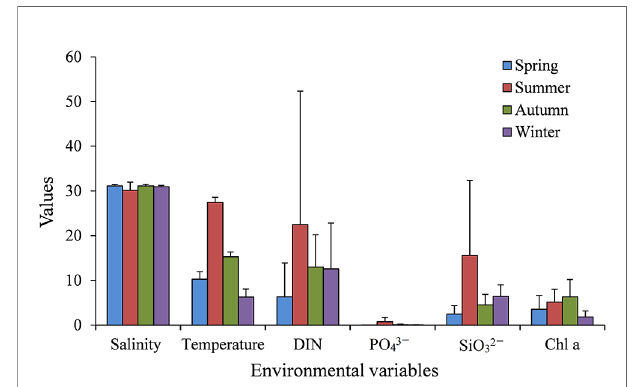
FIGURE 2 | Seasonal average values of key environmental variables, including salinity, temperature, DIN ( m M), PO 3 − 4 ( m M), SiO 2 − 3 ( m M), and Chl a ( m g L − 1 ) in